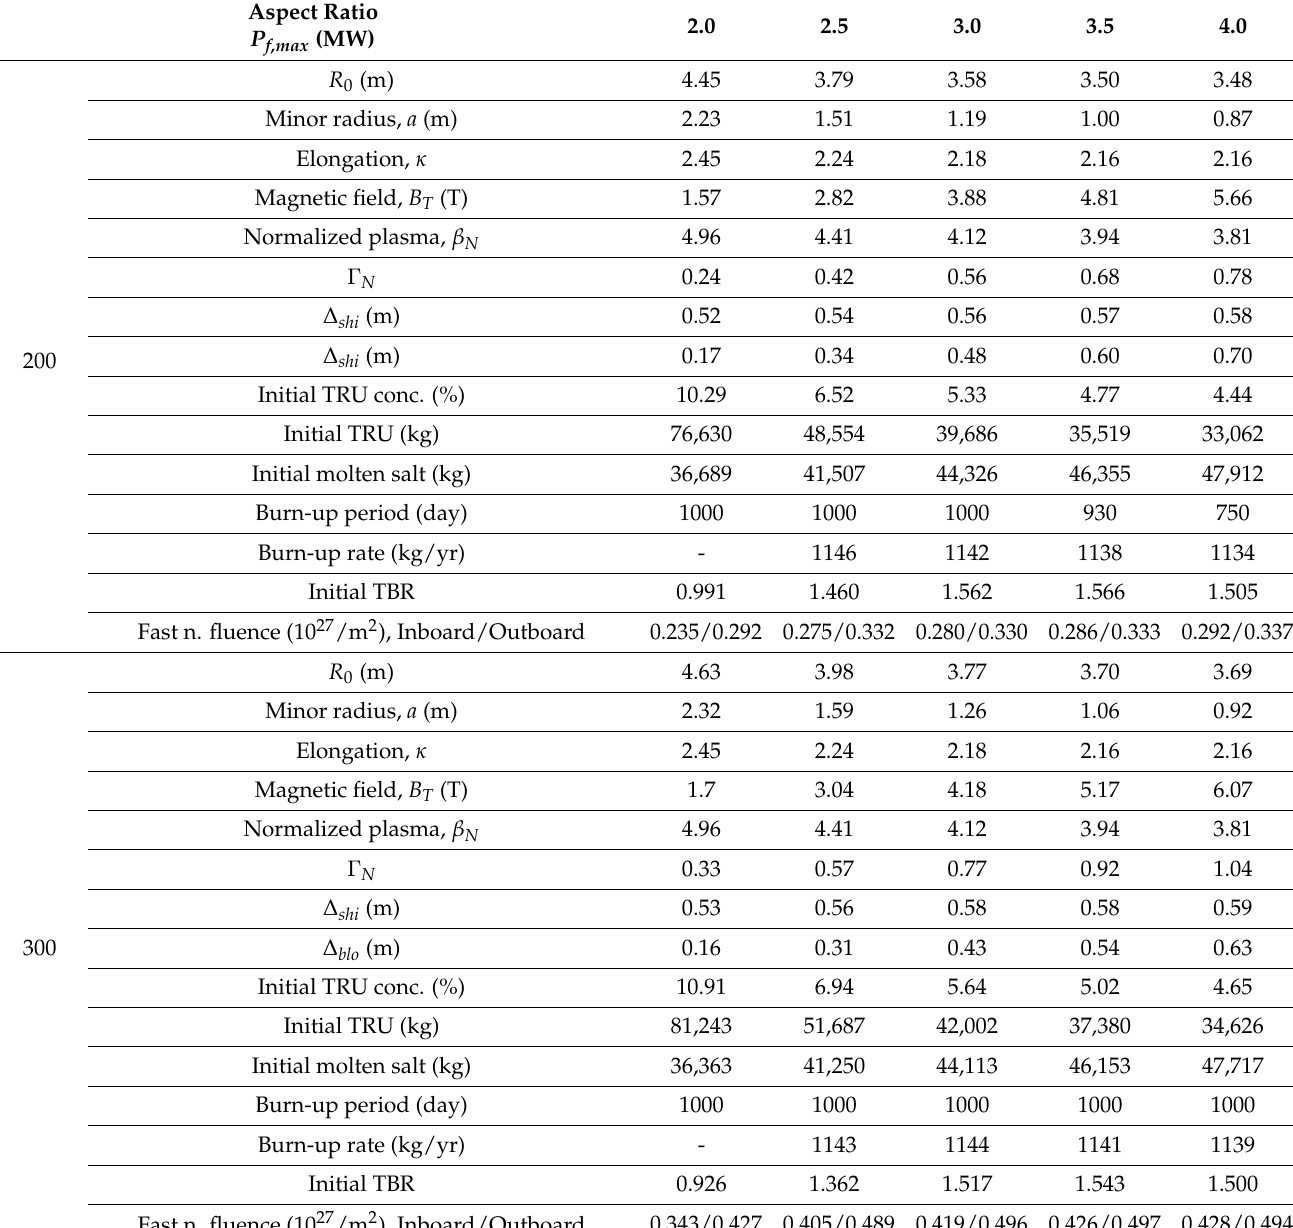
Table 4. System parameters and transmutation properties for various A and P f,max with